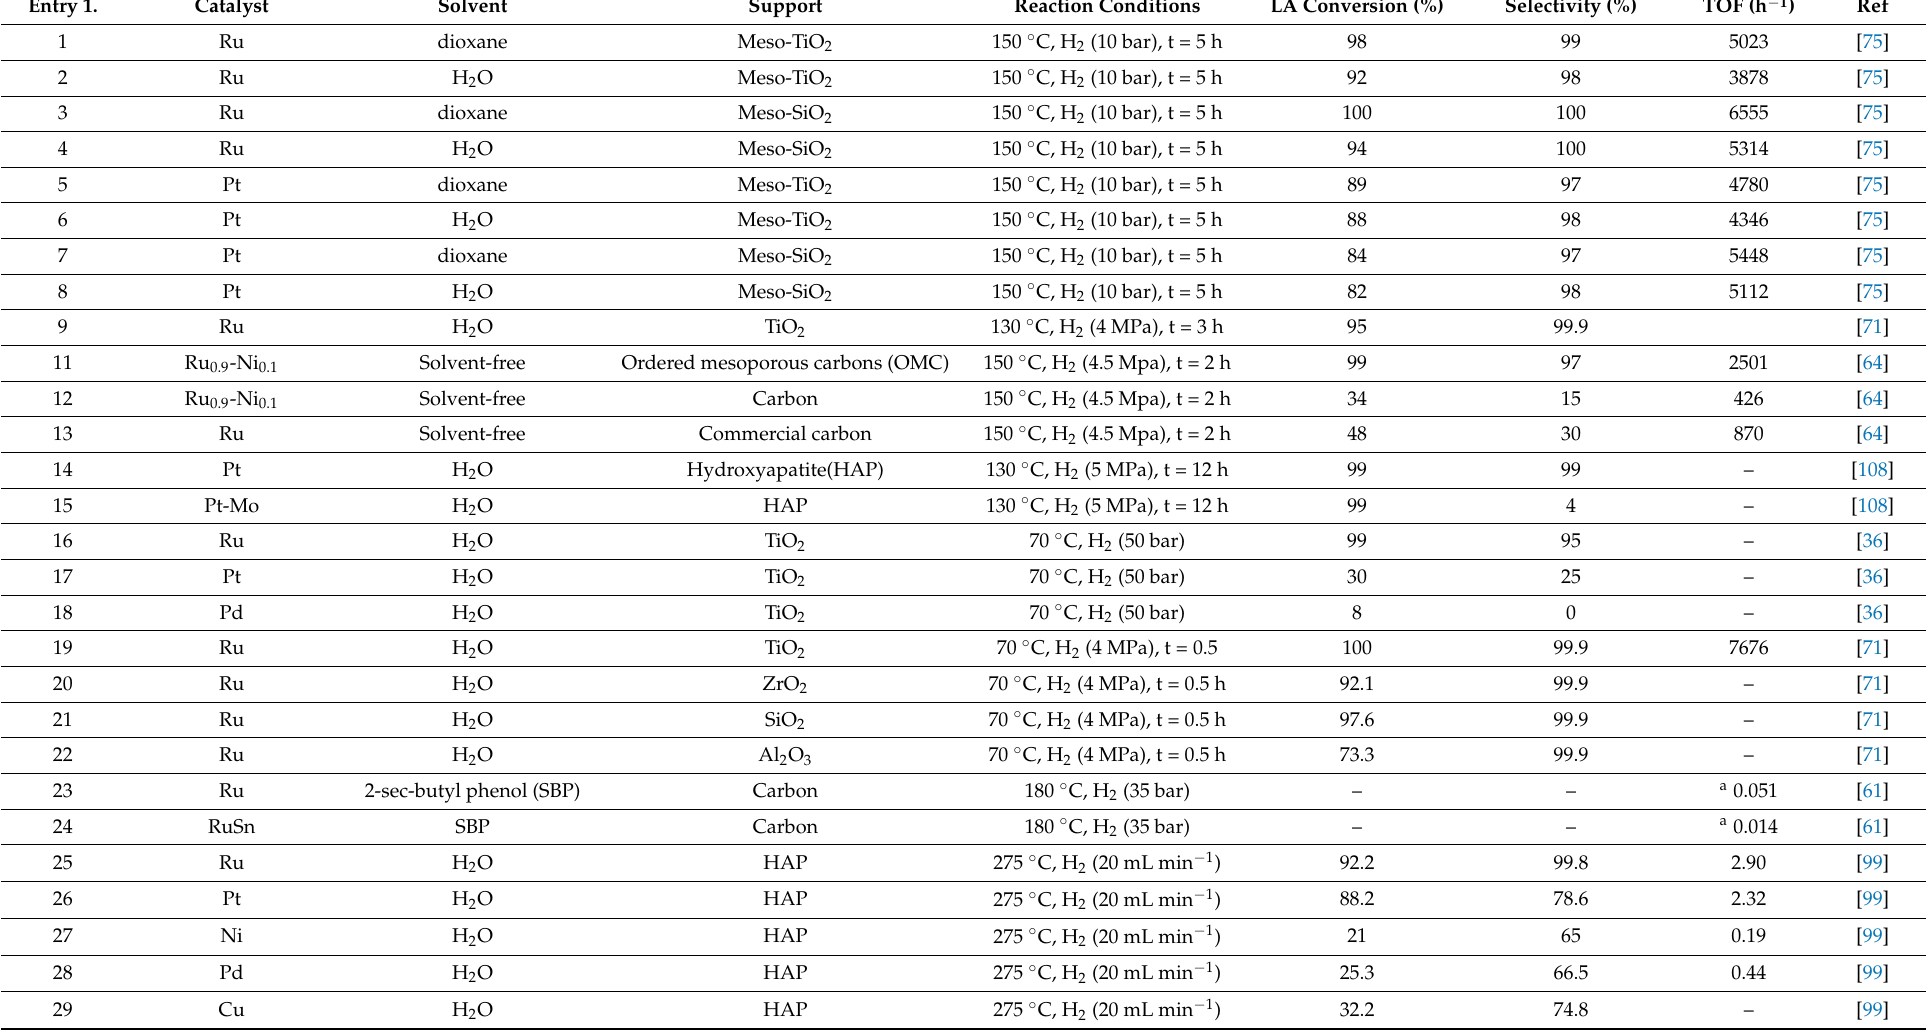
Table 1. A comparison of Reported Results for Supported-Ru Catalyzed Hydrogenation of LA to